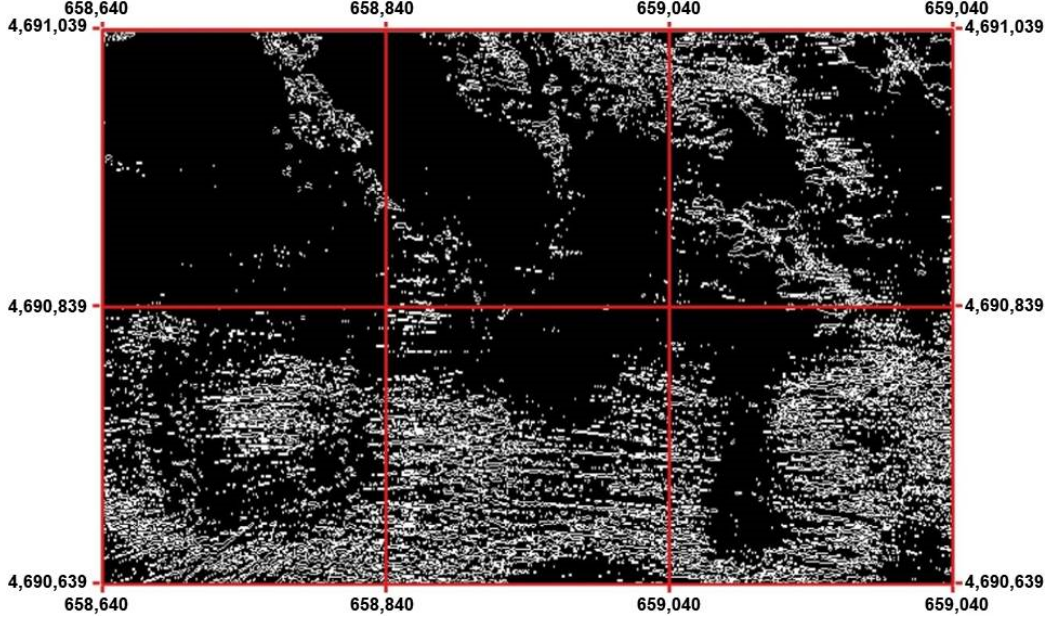
Figure 10. The image of the slope inversions along y direction in the study area (the pixels in which slope inversions occur are colored white).